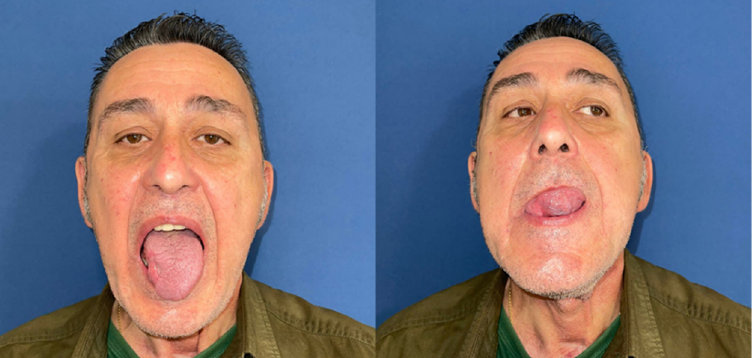
Figure 6. Aesthetic and functional results eight months after surgery with a FAMM flap for right tongue and floor of the mouth defect. Functional outcomes with lingual mobility: excellent tip elevation with open mouth and excellent tip protrusion, extending past lower vermillion border.